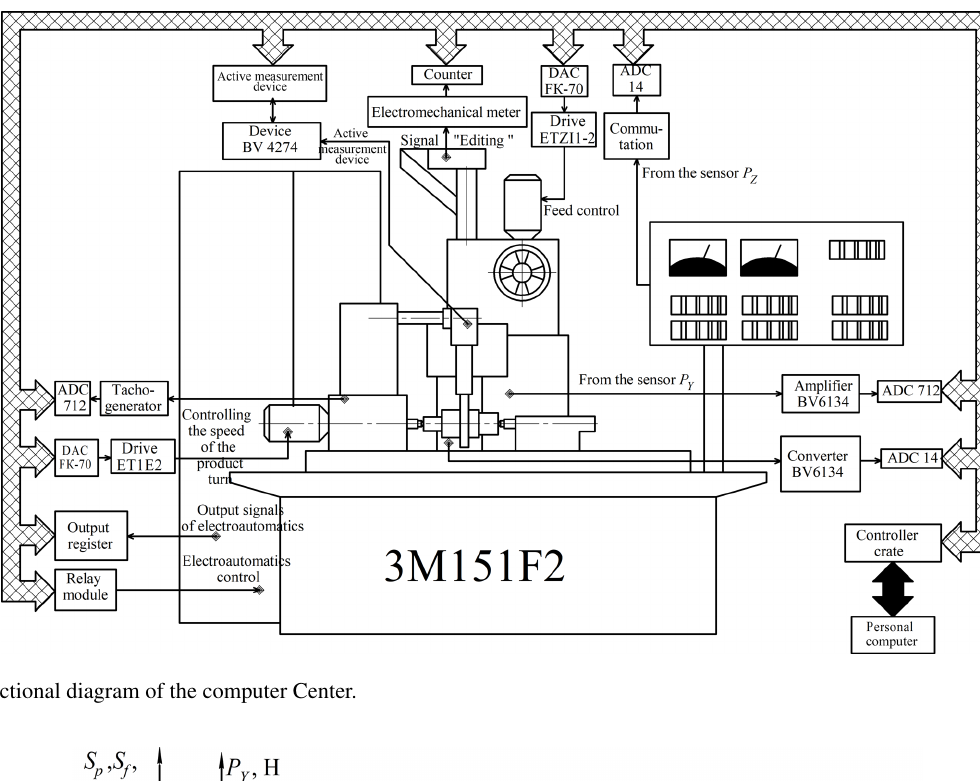
Figure 5. Functional diagram of the computer Center.